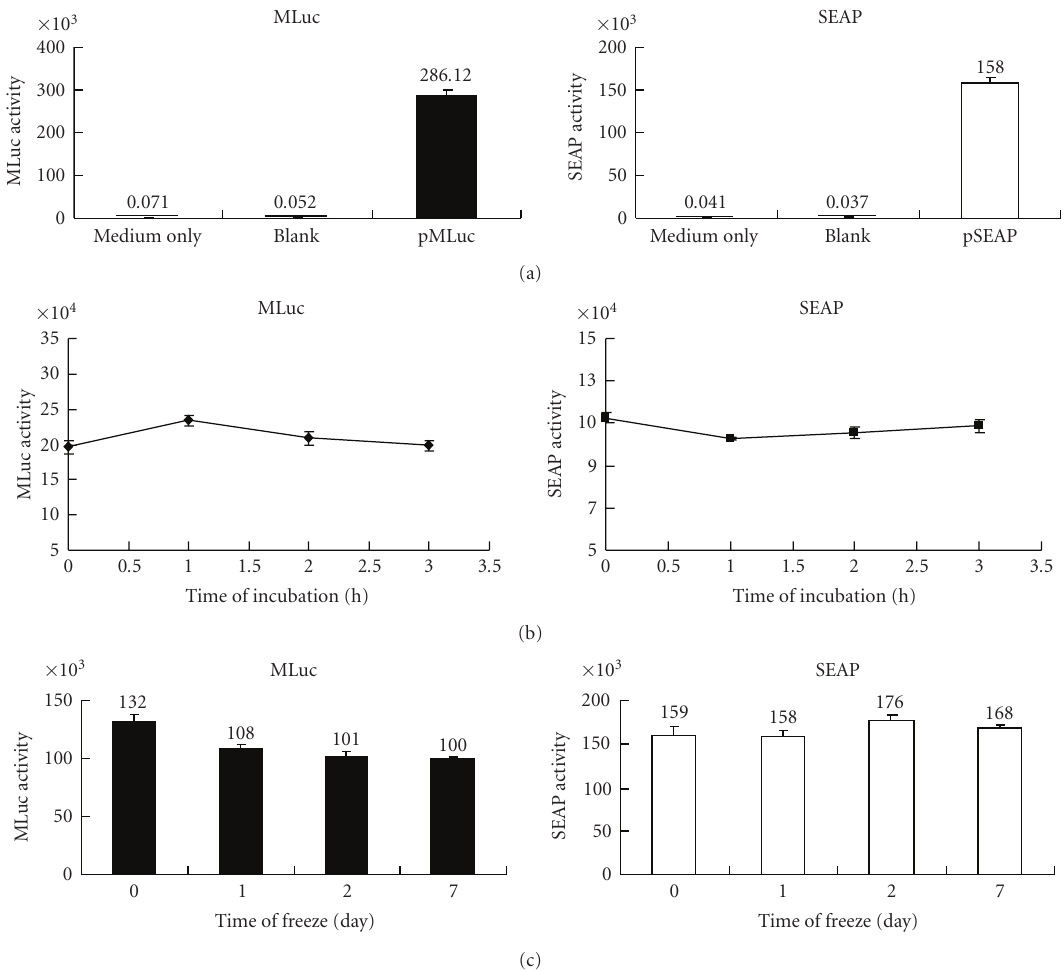
Figure 1: Characterization of the multisampling reporter system. HEK293T cells were grown in 6-well plates to 70% confluency, then some were left untreated and others were transfected with 0.5 μ g of pMLuc or pSEAP2-Control for 24 hours. (a) An aliquot of the medium was assayed for MLuc (left) or SEAP (right). (b) The culture medium was collected and incubated at 37 ◦ C in a 5% CO 2 humidified chamber and aliquots were withdrawn at di ff erent time points and assayed for MLuc (left) or SEAP (right). (c) Medium samples were frozen at − 20 ◦ C in separate Eppendorf tubes, and thawed at the indicated times, and assayed. The data presented are the mea n ± SD of